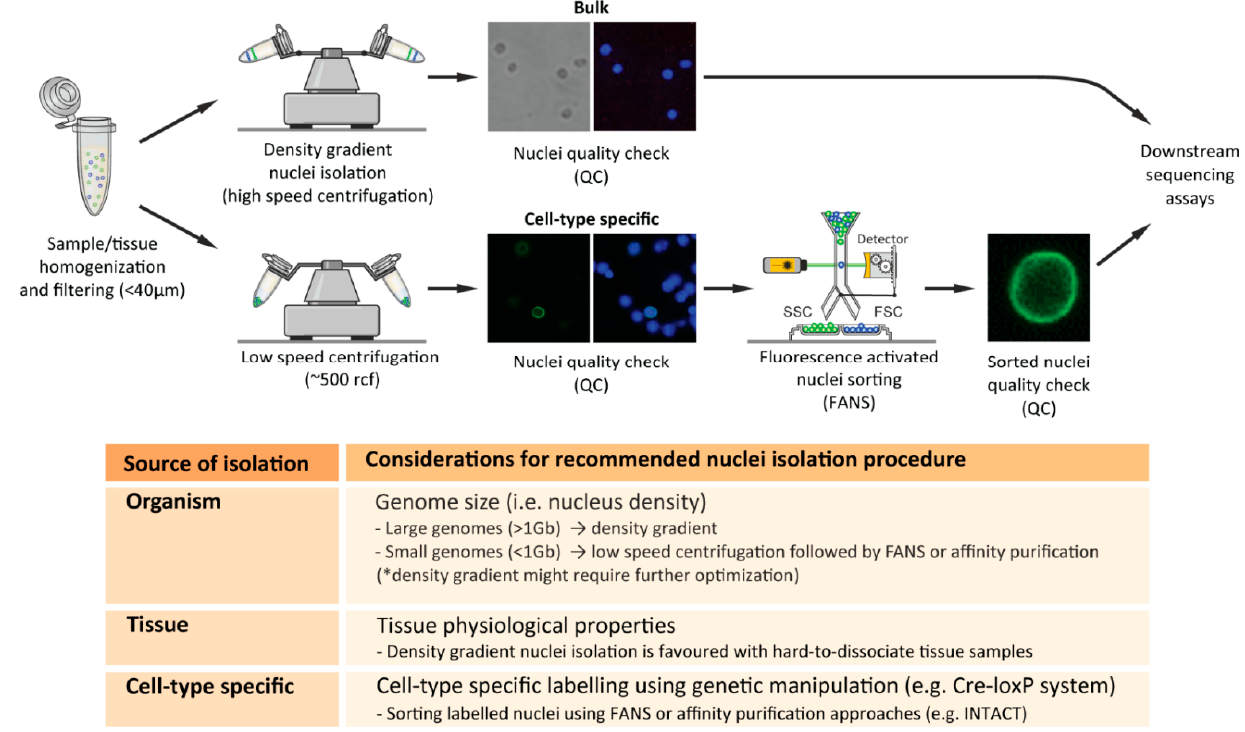
Figure 2. Overview of nuclei-isolation strategies and consideration of isolation method according to source material. source